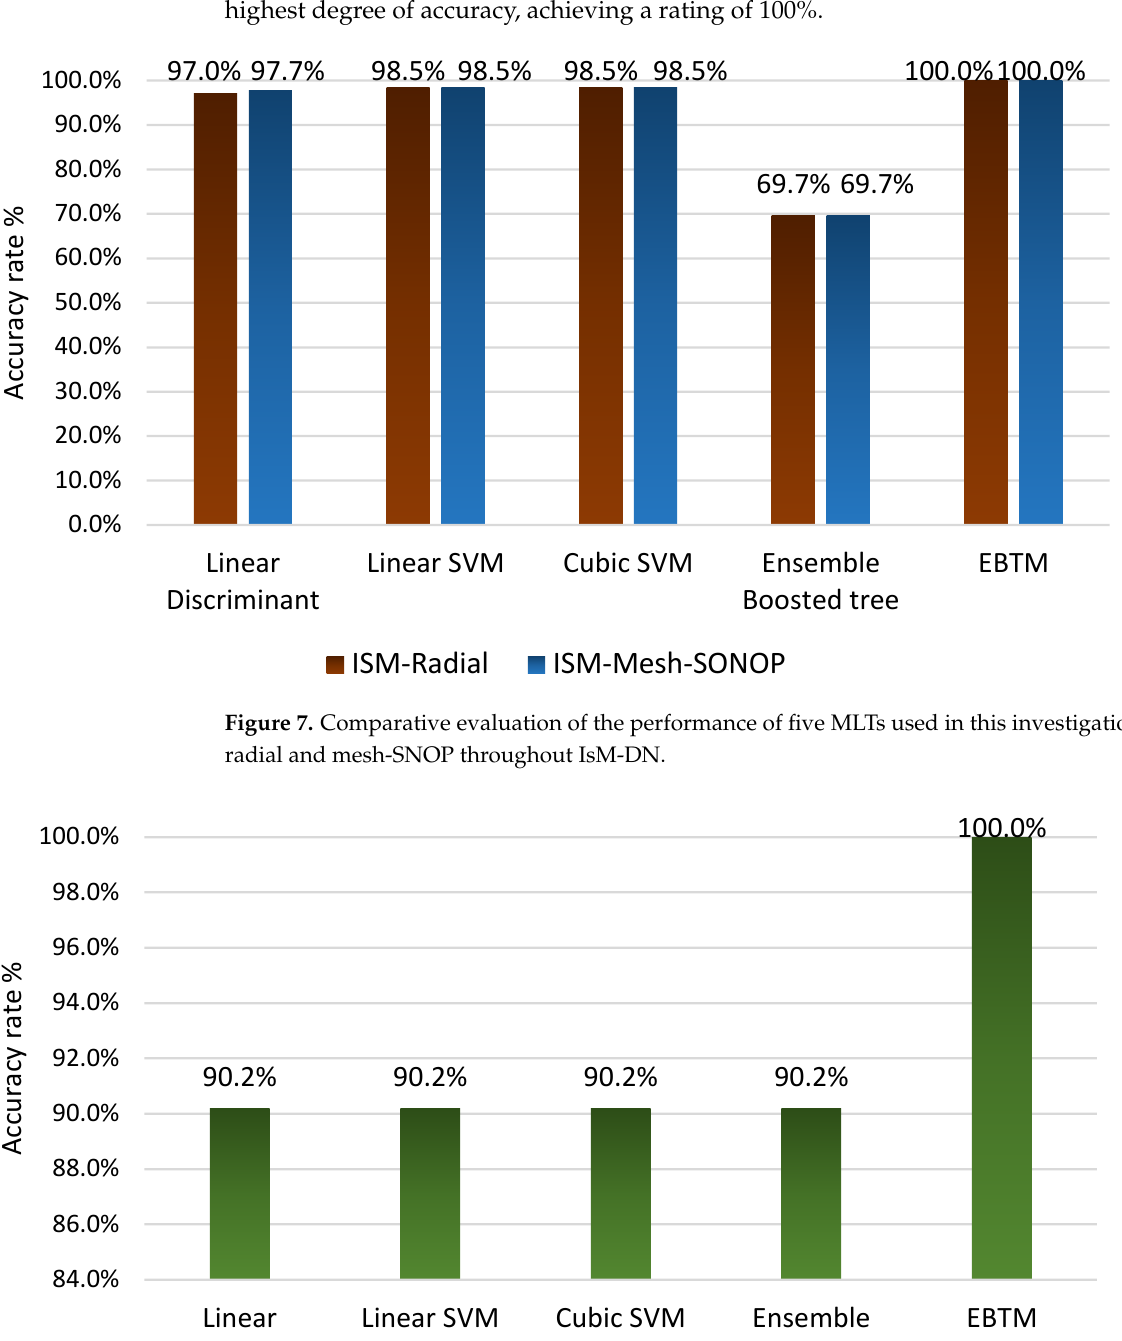
Figure 7. Comparative evaluation of the performance of five MLTs used in this investigation under radial and mesh-SNOP throughout IsM-DN.